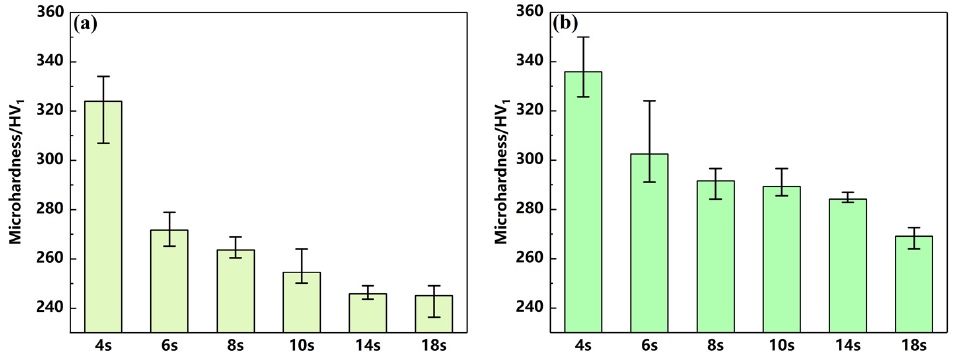
Figure 7. Distribution of microhardness test results for different t 8/5 values: ( a ) T max = 1150 °C; ( b ) T max = 1250 °C.